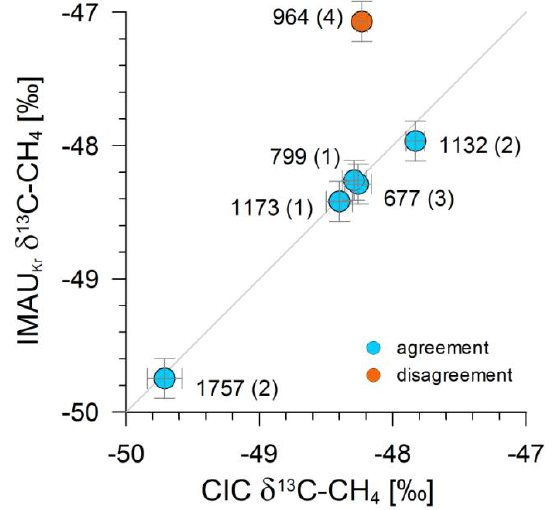
Fig. 8. Comparison of CIC and IMAU Kr δ 13 C-CH 4 ice core data (the index in IMAU Kr indicates the data have been corrected for the Kr-effect). Blue circles indicate data comparison of time sections where good agreement was found. The orange circle indicates the comparison where CIC and IMAU Kr found a disagreement of ~1 ‰. Error bars indicate the measurement uncertainty or the average of the measurements used for the laboratory comparison. Bracketed numbers indicate the numbers of samples measured at CIC for the respective comparison, while numbers without brackets display the time (AD) of the IMAU Kr